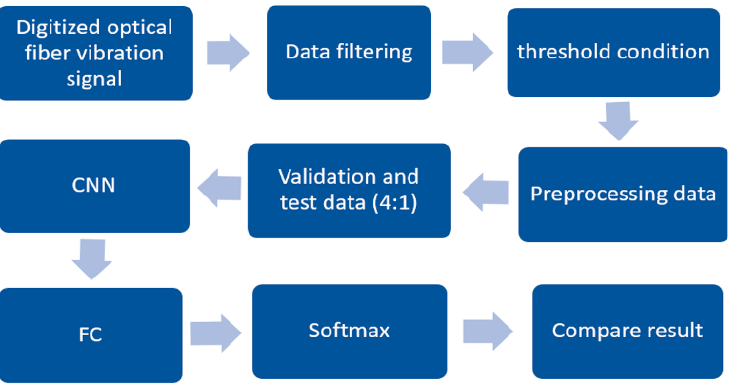
Figure 8. Block diagram of classifier training.